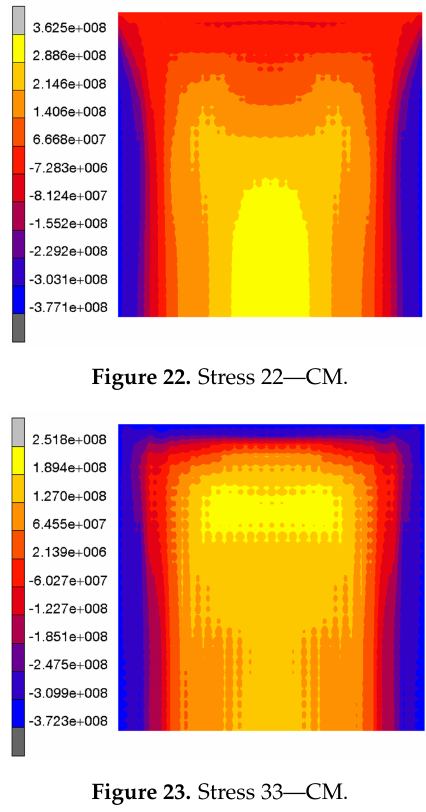
Figure 23. Stress 33—CM.